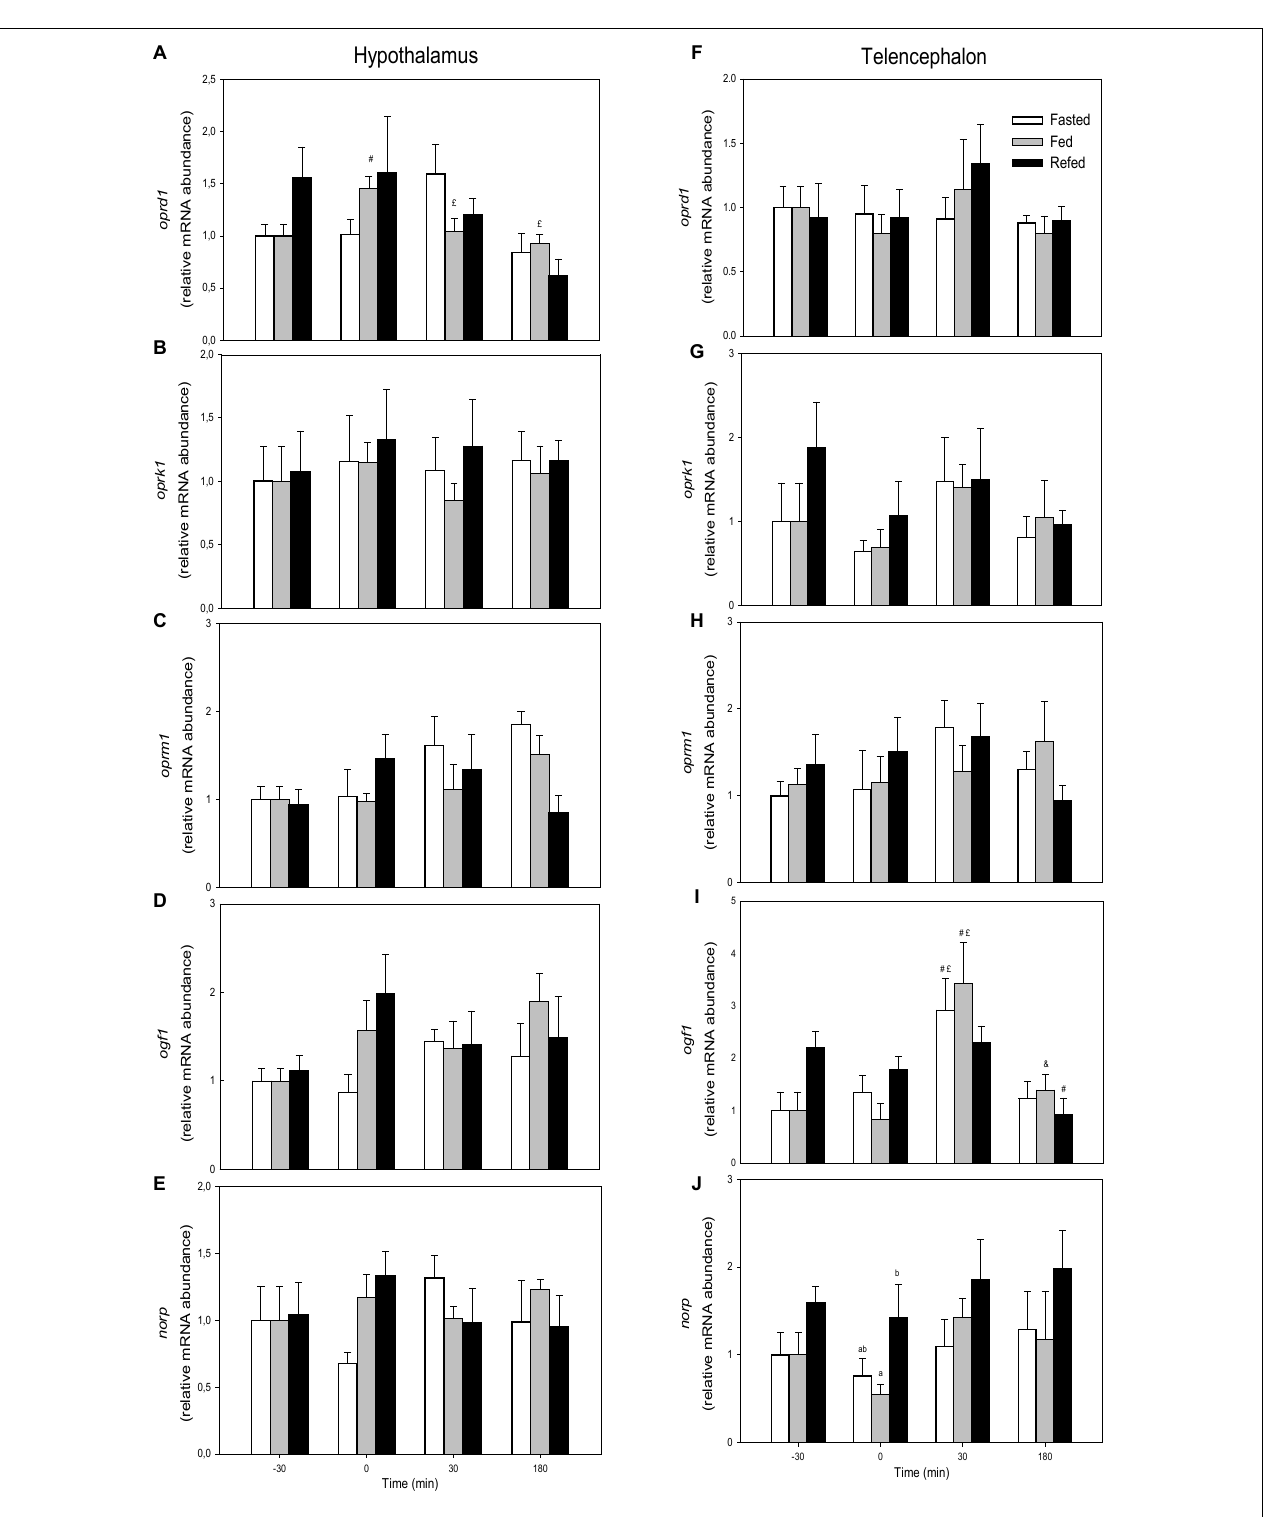
FIGURE 1 | mRNA abundance of oprd1 (A,F) , oprk1 (B,G) , oprm1 (C,H) , ogf1 (D,I) , and norp (E,J) in hypothalamus (A–E) and telencephalon (F–J) of fasted, fed an refed rainbow trout sampled at different periprandial times ( − 30, 0, 30, 180 min). Each value is the mean + S.E.M. of 6 fish. Different letters indicate significant differences ( P < 0.05) among feeding condition within each sampling time. # Significantly different from T = − 30 at the same treatment; £ significantly different from T = 0 at the same treatment; & significantly different from T = 30 at the same treatment.